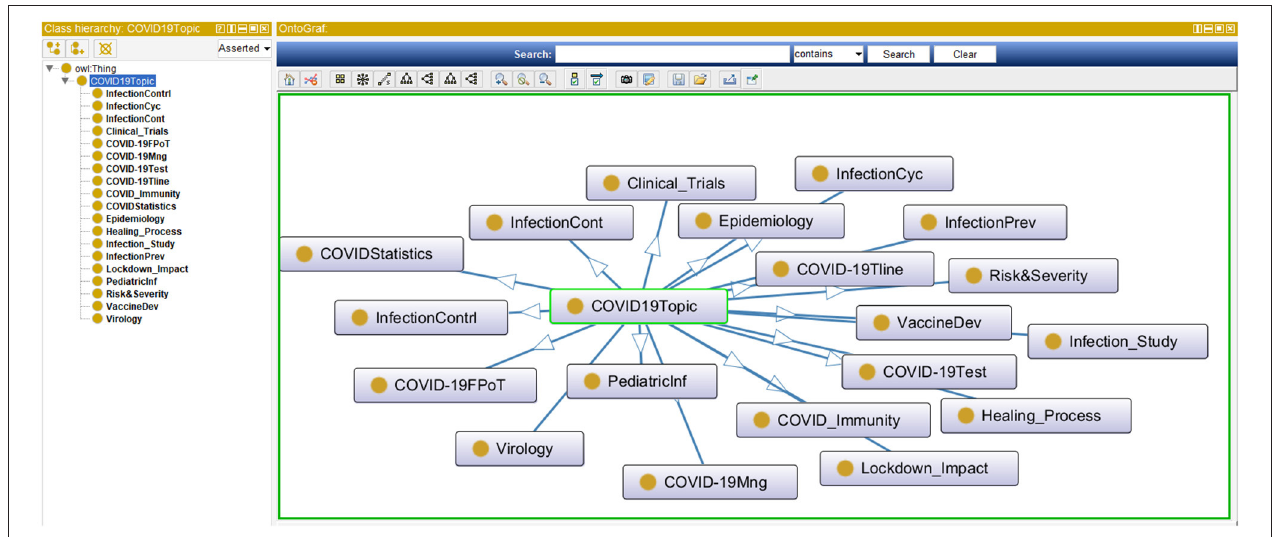
FIGURE 11 | The COVID-19 ontological class